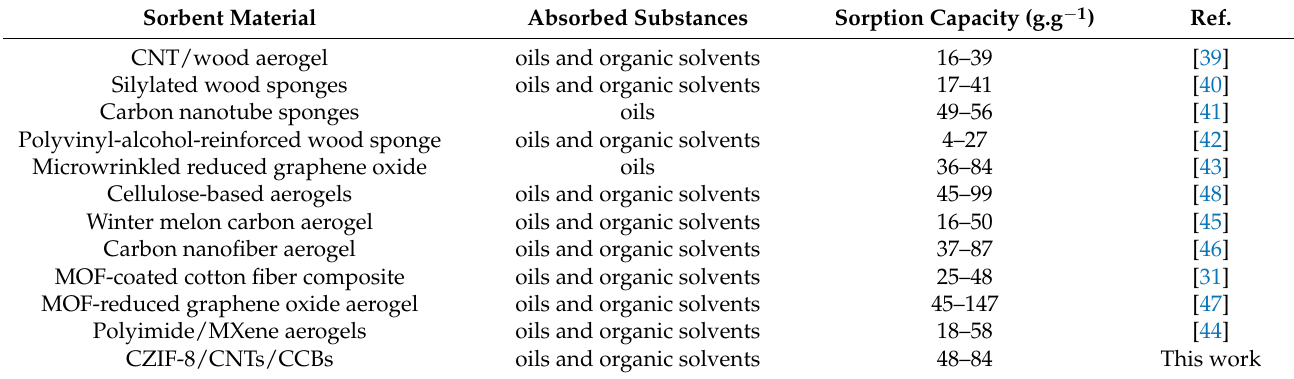
Figure 9. ( a ) Adsorption capacities Q 1 of CZIF-8/CNTs/CCBs and CCBs for oil or organic solvents. ( b ) Adsorption capacities Q 2 of CZIF-8/CNTs/CCBs and CCBs for oil or organic solvents. ( c ) Adsorption capacities of CZIF-8/CNTs/CCBs for n-heptane after 9 cycles. Table 1. Comparison of various sorbent